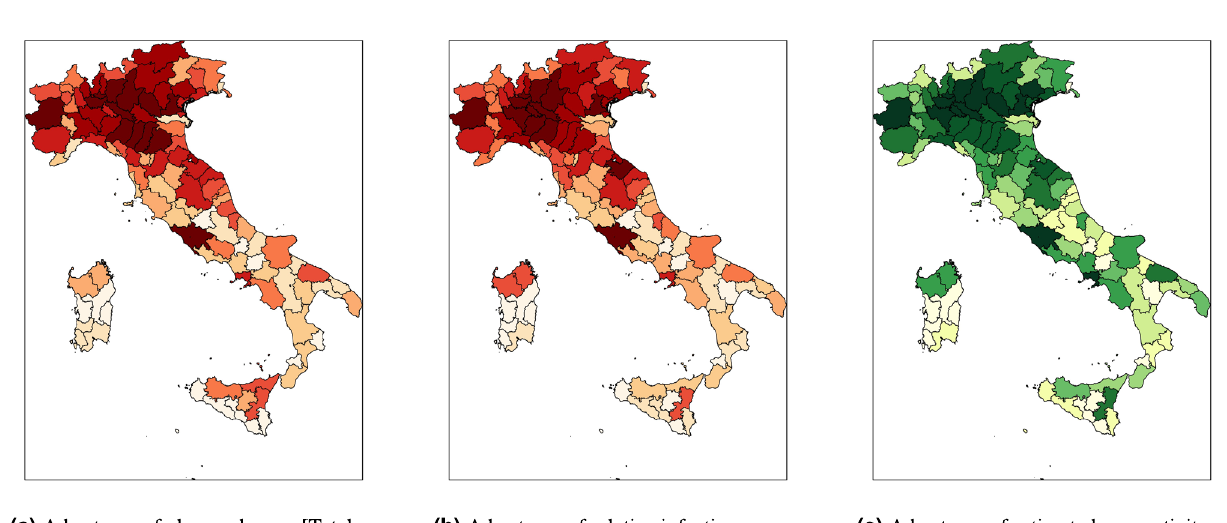
Figure 3. Spatial distributions of estimated infection prevalence and observed new COVID-19 cases in Italy in the week ending 28 March 2020. Top twenty provinces for likely intervention in the order of their rank (by